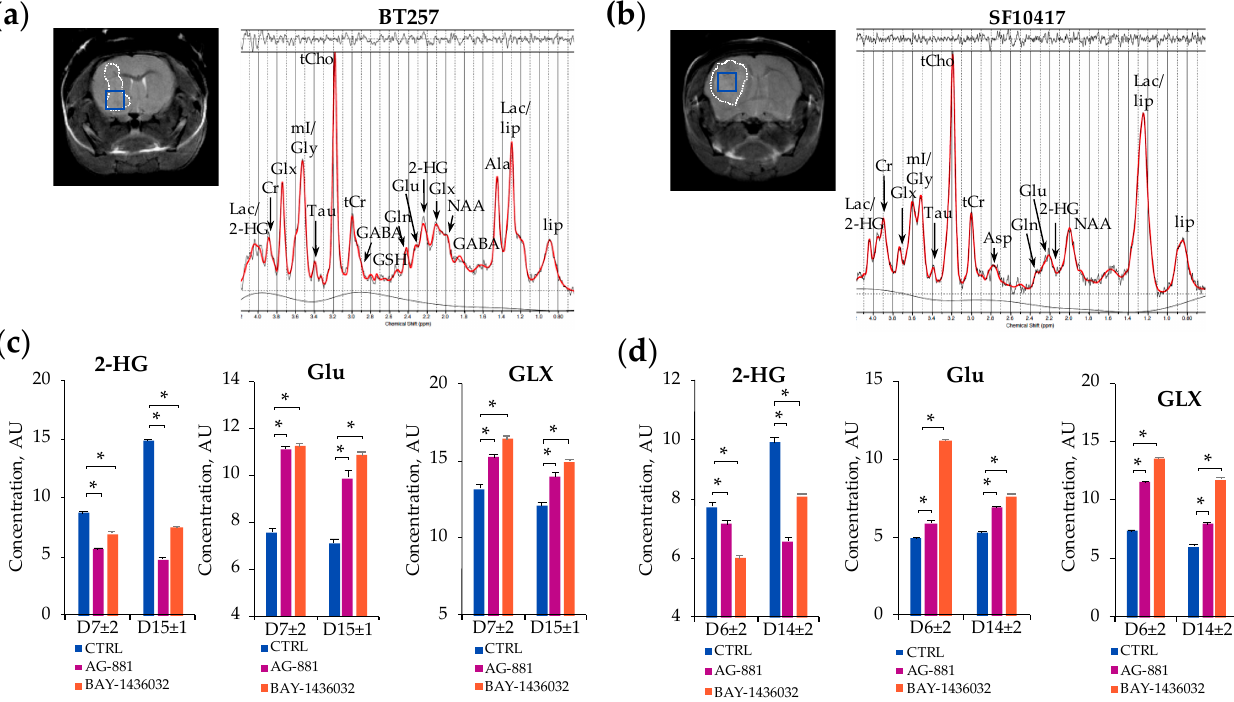
Figure 4. Representative axial T 2 -weighted images of control BT257 ( a ) and SF10417 ( b ) tumor-bearing mice and corresponding in vivo 1 H-MRS spectra acquired from 2 × 2 × 2 mm 3 voxel marked inside the tumor region in blue ( a , b ). Quantification of 2-HG, Glu and GLX metabolites in control, AG-881- and BAY-1436032-treated tumors at D7 ± 2 and D15 ± 1 in the BT257 ( c ), and at D6 ± 2 and D14 ± 2 in the SF10417 models (* p -value < 0.003) ( d ).